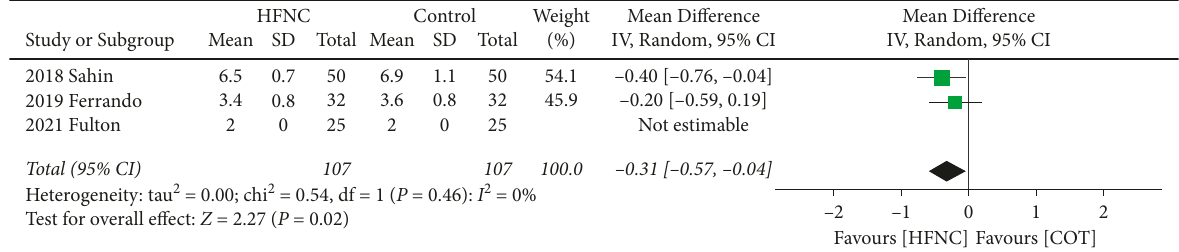
Figure 7: Forest plot comparing hospital LOS between HFNC and